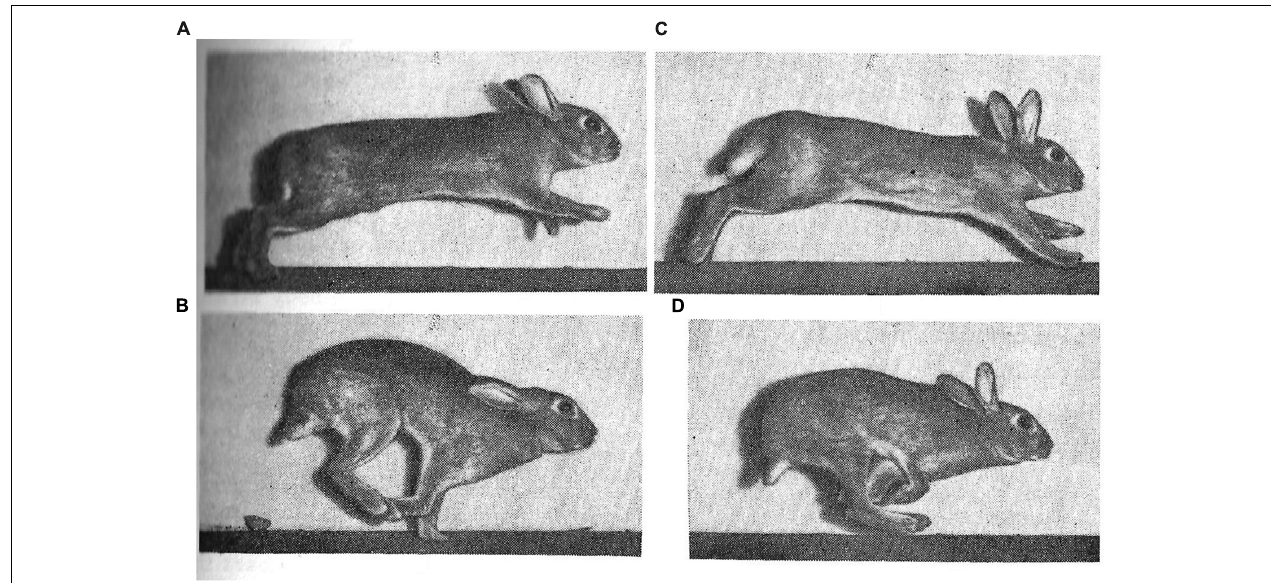
FIGURE 4 | Stages of wild rabbit ( O. cuniculus ) gait as captured and described by Gambaryan (1974), including: (A) support on hindlimbs; (B) extended flight; (C) support on forelimb; and (D) crossed flight.